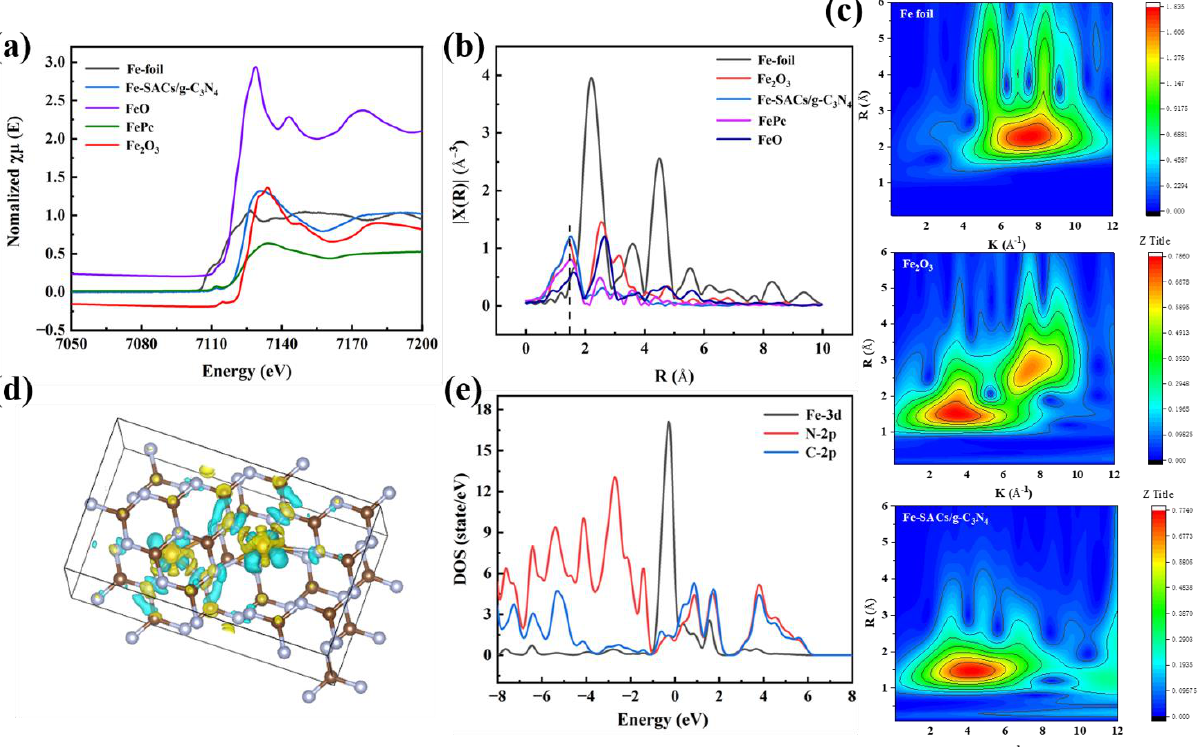
Figure 4. ( a ) XANES spectra at the Fe Kedge of FeSACs/gC 3 N 4 and reference samples; ( b ) FT k 3 weighted EXAFS spectra of FeSACs/gC 3 N 4 and reference samples; ( c ) WT plot of Fe-SACs/g-C 3 N 4 ; ( d ) Differential charge density of the Fe-N 4 coordination systems (The blue regions illustrate charge depletion while the green regions indicate charge accumulation); ( e ) Density of states of the Fe-N 4 coordination systems.